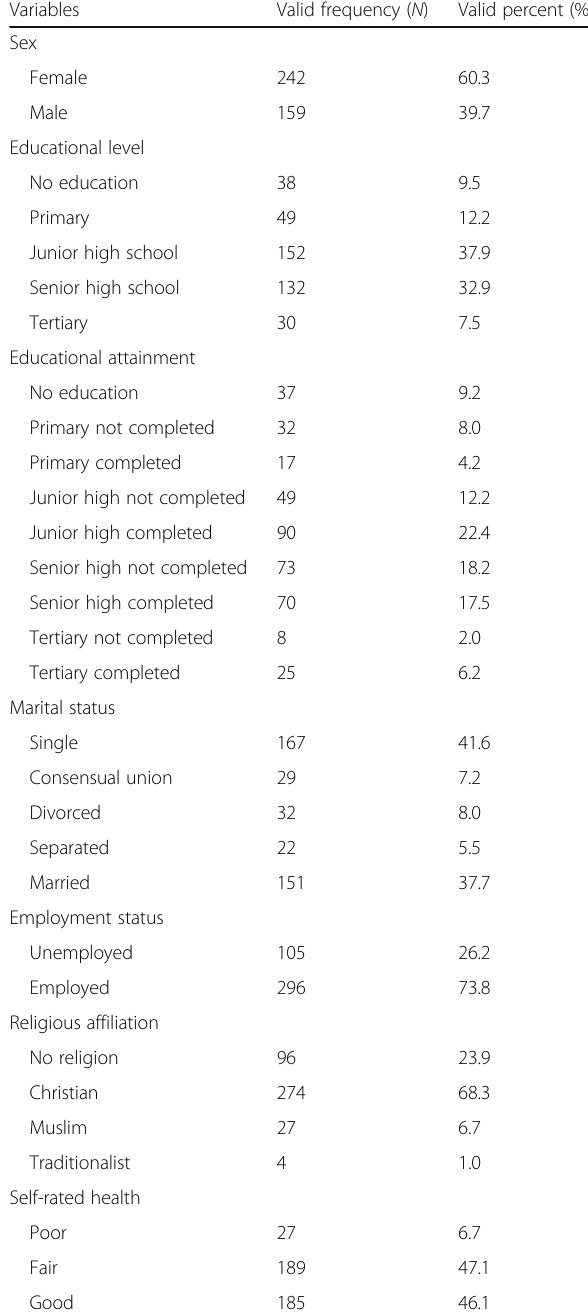
Table 1 Characteristics of the study participants